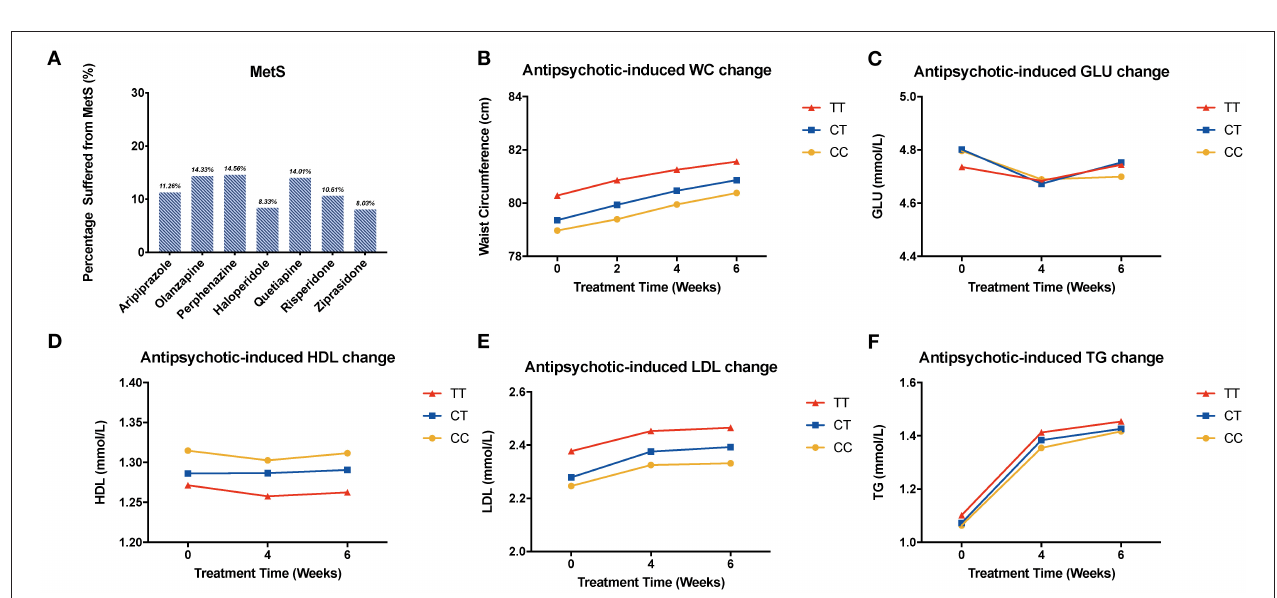
FIGURE 2 | Association of MTHFR C677T polymorphism with antipsychotic-induced MetS and metabolic indices change. WC, waist circumference; GLU, glucose; HDL, high-density lipoprotein; LDL, low-density lipoprotein; TG, triglyceride. (A) shows the percentage of patients suffering from metabolic syndrome after being treated with different kinds of drugs. (B–F) show the change of metabolic components of all the patients.